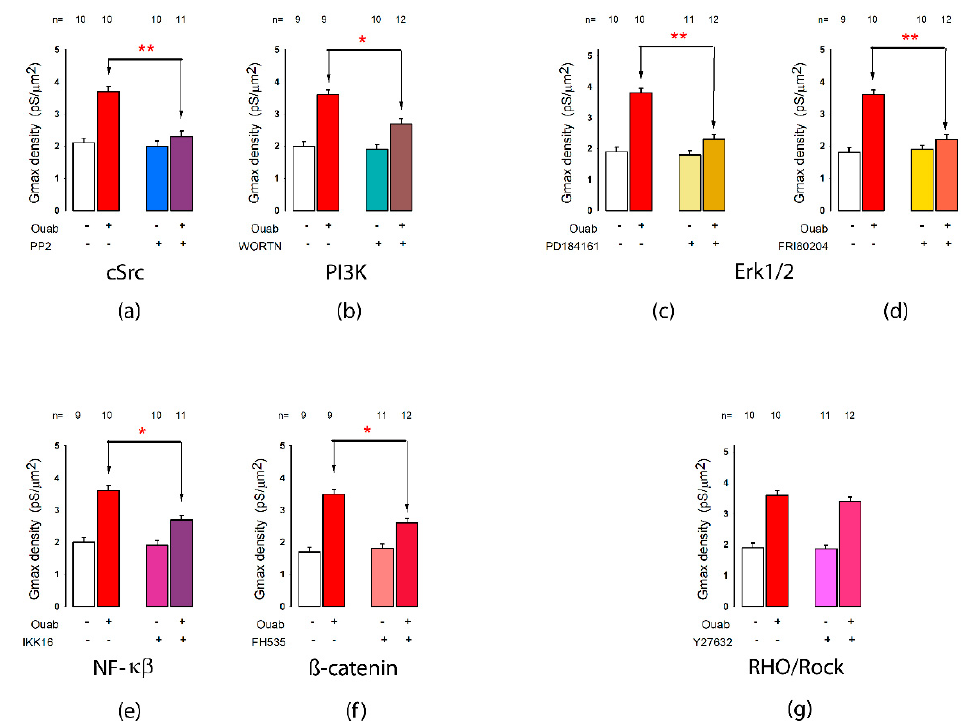
Figure 8. Signaling pathways involved in ouabain-induced changes to I K . Bar graphs ( a – g ) show the effect on the ouabain-induced enhancement of δ G max , of the various kinase inhibitors, as indicated at the bottom of each bar graph. Each bar graph compares the mean ( ± SE) value of δ G max , obtained from current records of individual cells in MEMs which were treated or not with ouabain for 6 hours and treated or not with the different inhibitors as indicated at the bottom of the bars. The number of repetitions in each group is indicated above each bar. Asterisks indicate a statistically significant difference between the groups indicated by the arrows. (*) indicates a p < 0.05 and (**) p < 0.001.